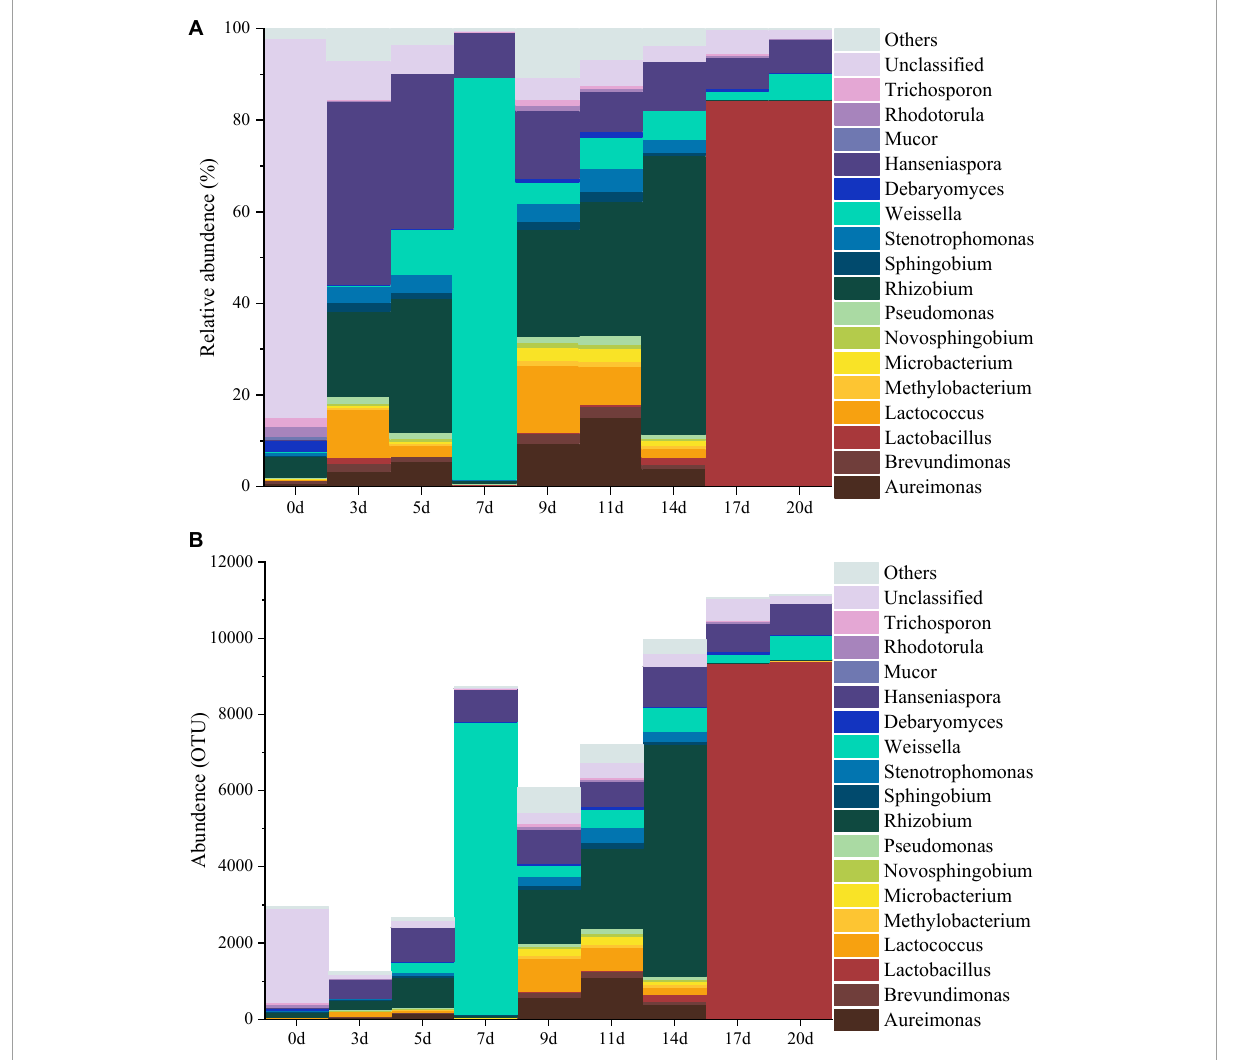
FIGURE1 Dynamics of the relative abundance (A) and abundance (B) of microorganisms at the genus level during the production of fermented minced peppers.